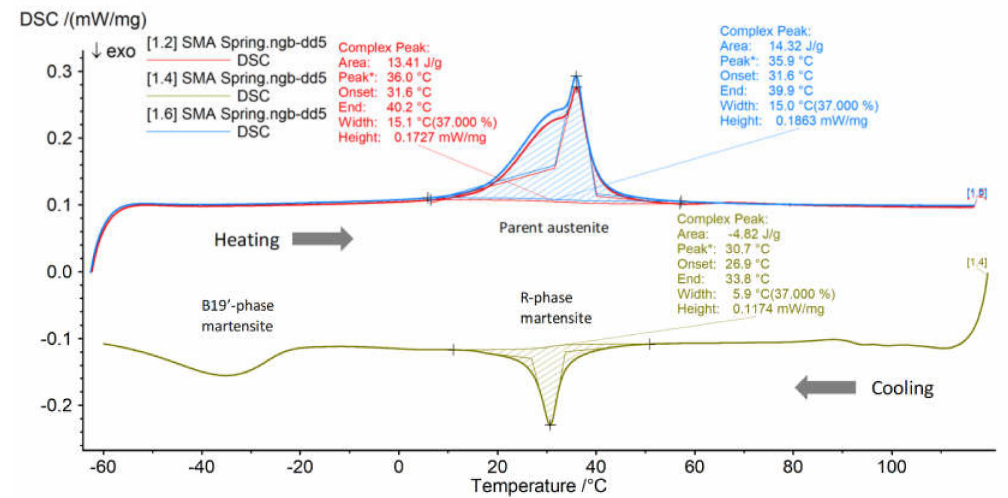
Figure 5. DSC curves: The peak during cooling indicates a symmetric R-phase transformation (blue: austenite upon the first heating; red: austenite during the second heating).